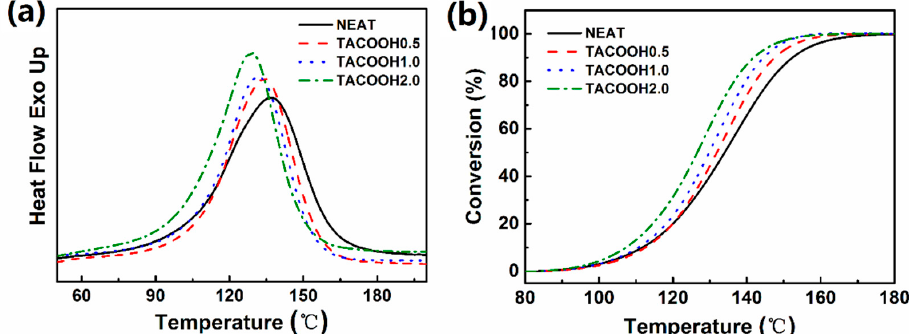
Table 1. DMA and DSC results of the neat epoxy and TA–COOH modified epoxy resins. Sample